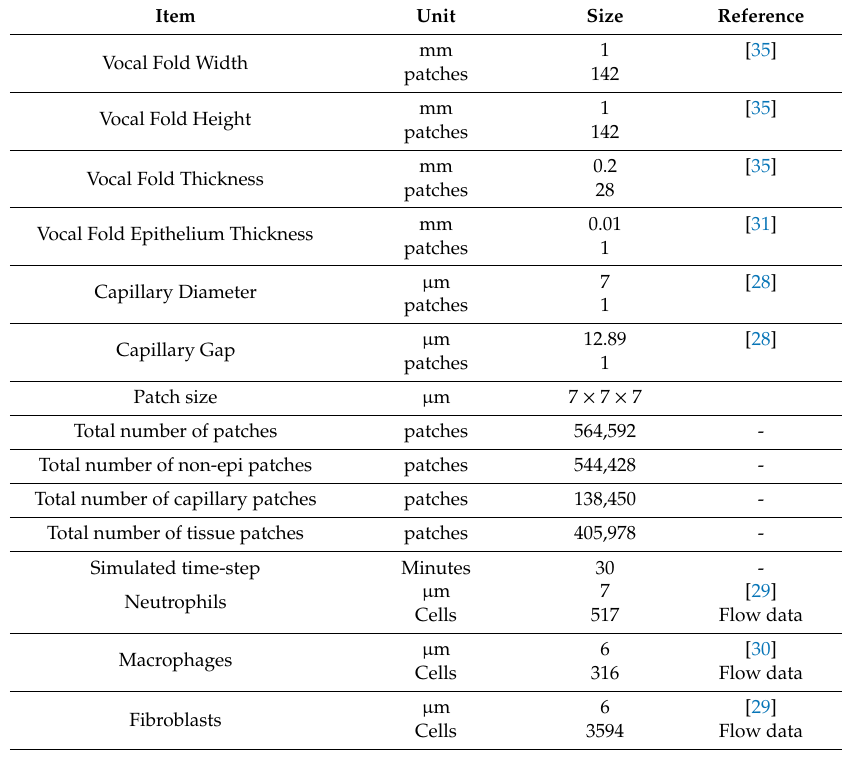
Table 4. Initial configurations of